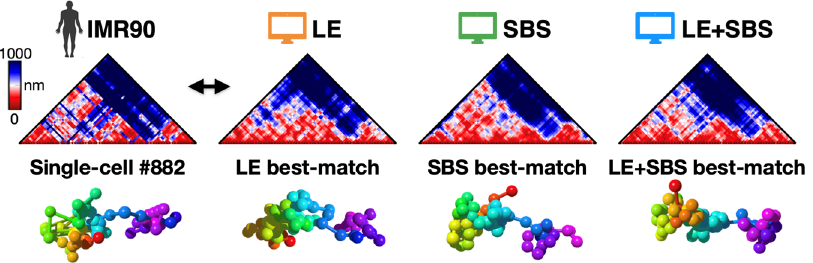
Figure 3. Example of experiment-model best-matching 3D structures, along with their correspond- ing single-molecule distance maps, as identified by the RMSD method. Adapted from [28].